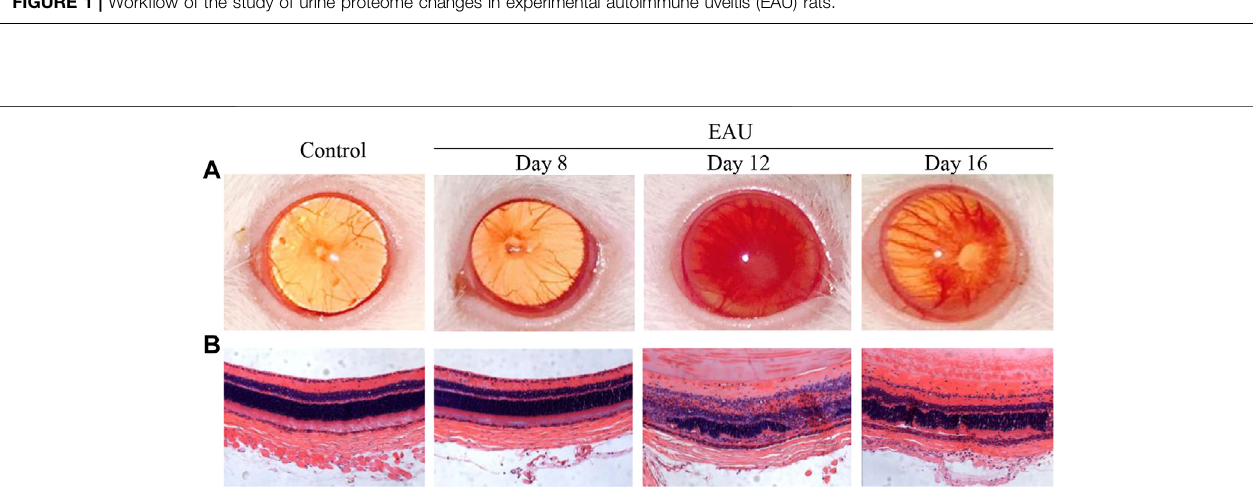
FIGURE 1 | Work fl ow of the study of urine proteome changes in experimental autoimmune uveitis (EAU) rats.